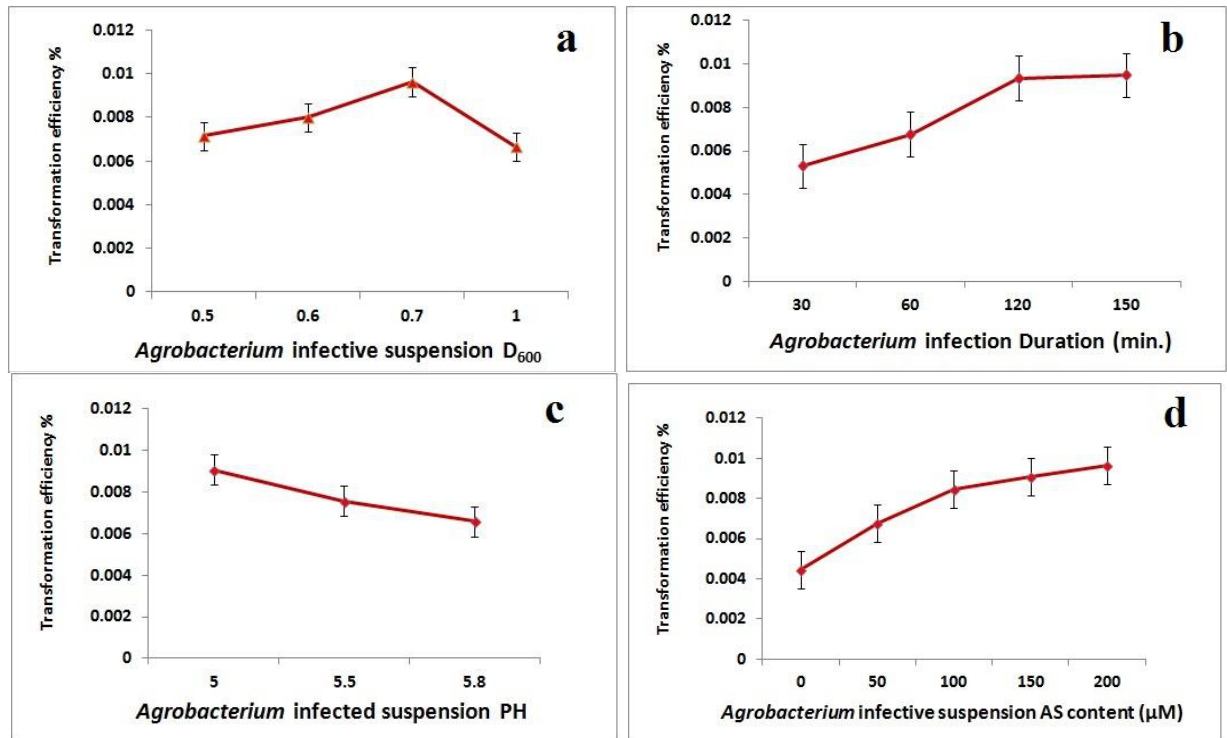
Figure 4. The effects of various factors on Agrobacterium -mediated transformation efficiency: ( a ) Agrobacterium concentration; ( b ) Agrobacterium infection duration; ( c ) Agrobacterium suspension pH; ( d ) acetosyringone (AS) concentration; ( e ) cold pre-treatment; ( f ) cocultivation temperature; ( g ) cocultivation duration; ( h ) cocultivation medium sucrose